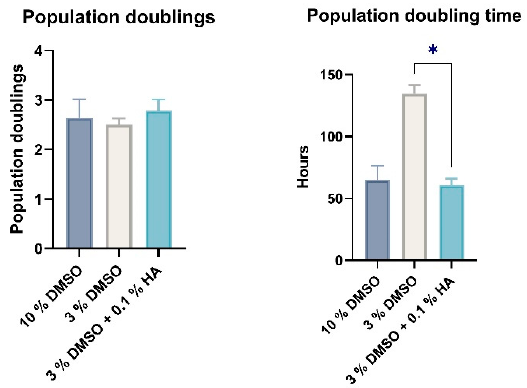
Figure 5. Population doublings and population doubling time of all cell groups reached from cell thawing to period of time when we induced differentiation. Data are presented as a mean and SD plotted as error bars. The statistical significances (* p < 0.05) were calculated using either one-way ANOVA, followed by Dunnett’s multiple comparison test for continuous variables, or Friedman’s test, followed by Dunn’s multiple comparison test on ranks for nonparametric variables. The Shapiro–Wilk test or Kolmogorov–Smirnov test were used for normal distribution evaluations.